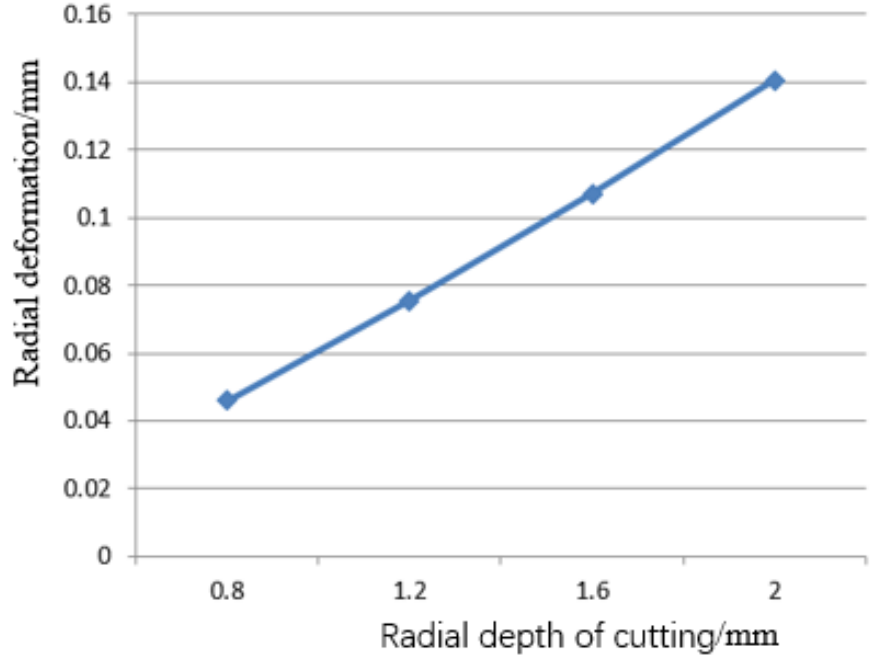
Figure 13. Influence of radial depth of cutting on machining deformation.